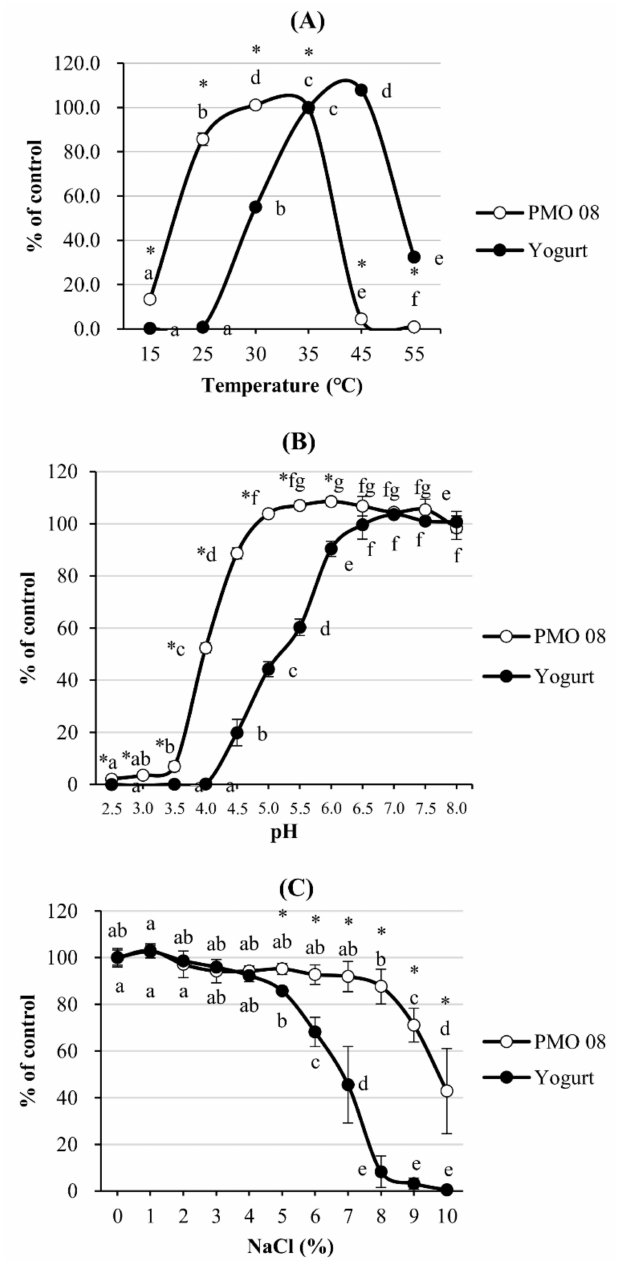
Figure 1. E ff ect of culture conditions on bacterial cell growth. ( A ) Temperature, ( B ) pH, and ( C ) NaCl concentration. PMO 08: Lactobacillus plantarum PMO 08; Yogurt: Starter culture mixture of Lactobacillus acidophilus, Streptococcus thermophilus, and Bifidobacterium lactis . All values are presented as mean ± standard deviation (n = 3). Values with di ff erent letters are significantly di ff erent at p < 0.05 according to Duncan’s multiple range test. * Significant di ff erence between PMO 08 and yogurt ( p <